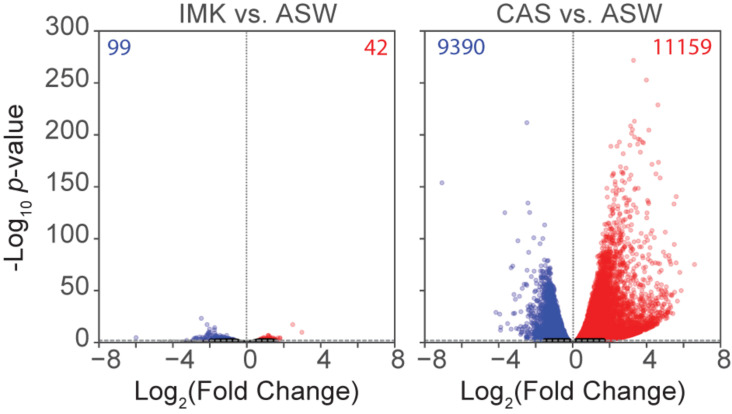
Expression in SSB01 in IMK + CAS or IMK compared to ASW. Volcano plot of relative abundances of individual transcripts in IMK vs. ASW and IMK + CAS vs. ASW. x-axis, fold-changes; y-axis, adjusted p-values based on Benjamini-Hochberg correction; red dots indicate transcripts more abundant in IMK (left) or in IMK + CAS (right). Blue dots indicate transcripts more abundant in ASW. Both axes use log scales. The horizontal line indicates adjusted p-values = 0.001, the cutoff used for considering differences to be significant.